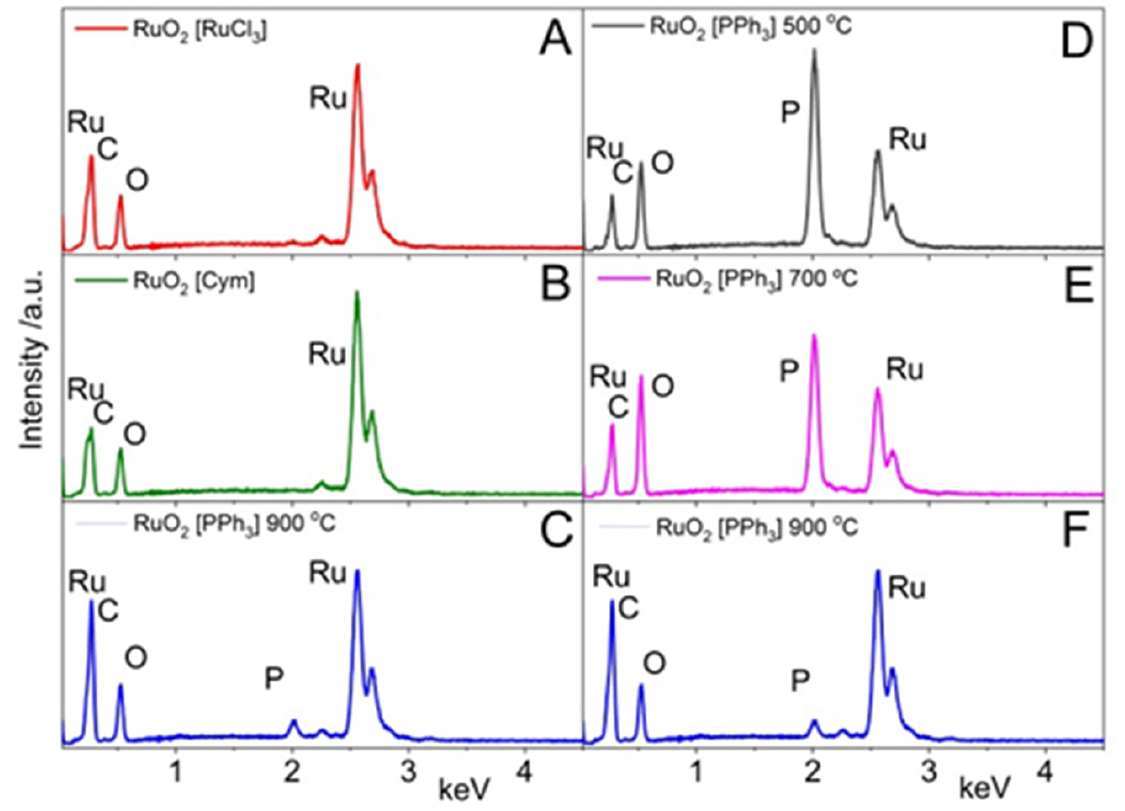
Figure 2. Energy Dispersive X-ray (EDX) spectra of the calcined materials obtained at 900 °C in static air: ( A ) RuO 2 [RuCl 3 ]; ( B ) RuO 2 [Cym]; ( C ) RuO 2 [PPh 3 ] and EDX spectra of calcined [RuCl 2 (PPh 3 ) 3 ] at three different temperatures: ( D ) 500 °C, ( E ) 700 °C, and ( F ) 900 °C in the same conditions.